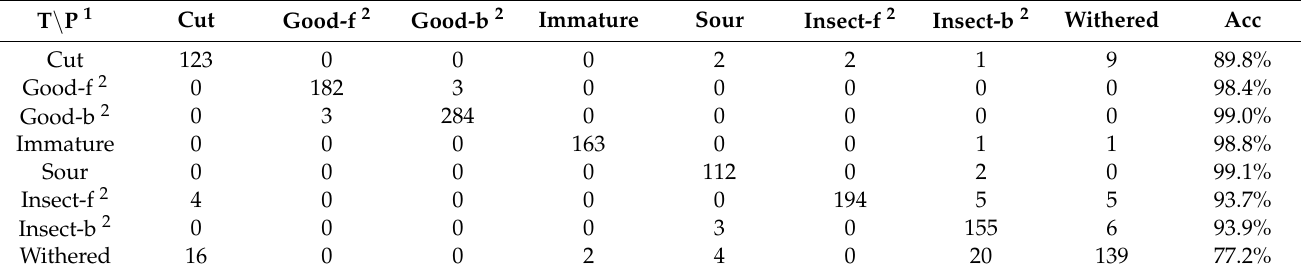
Figure 9. Convolution visualization results of the AlexNet-aj model (the columns of images from left to right represent the results obtained for Convolutional Layers 1–5). Table 8. Confusion matrix of the new network-dr